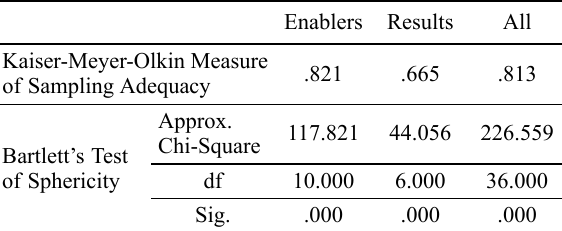
Table 5. KMO and Bartlett’s test of the three constructs